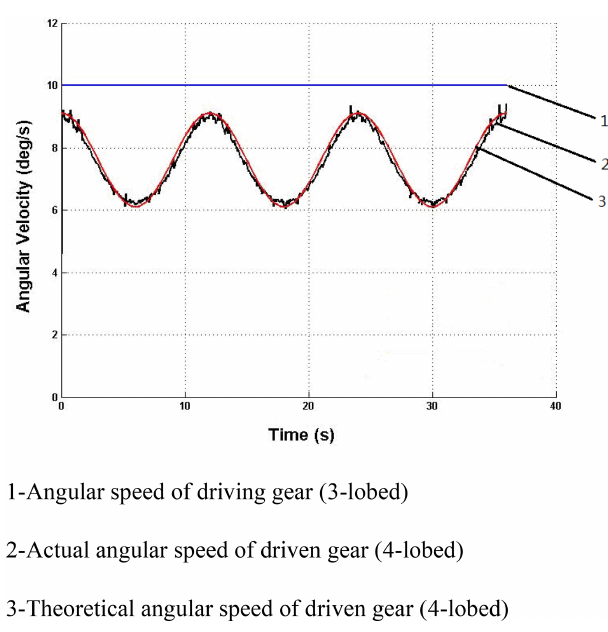
Figure 6. Transmission ratio